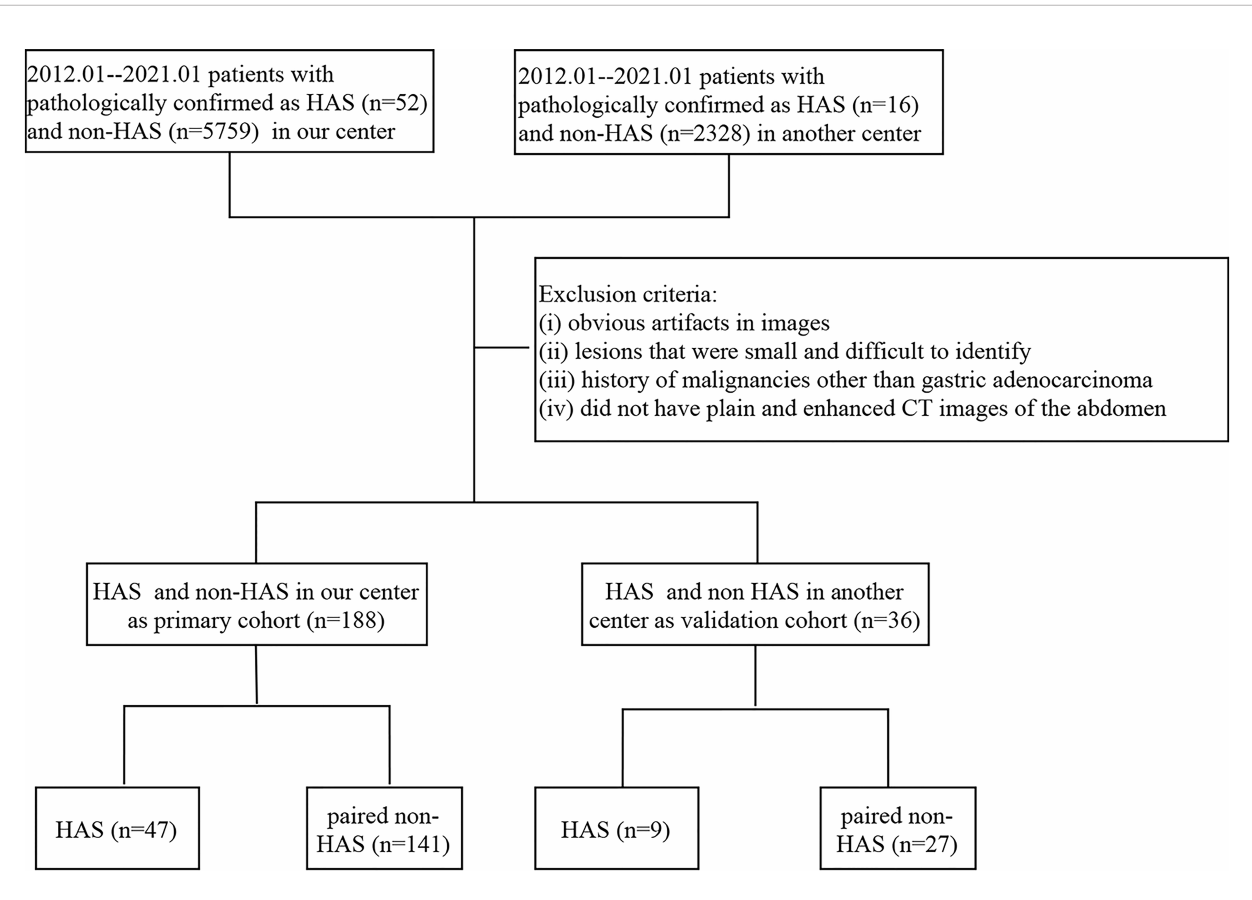
FIGURE 1 | The patient enrollment work fl